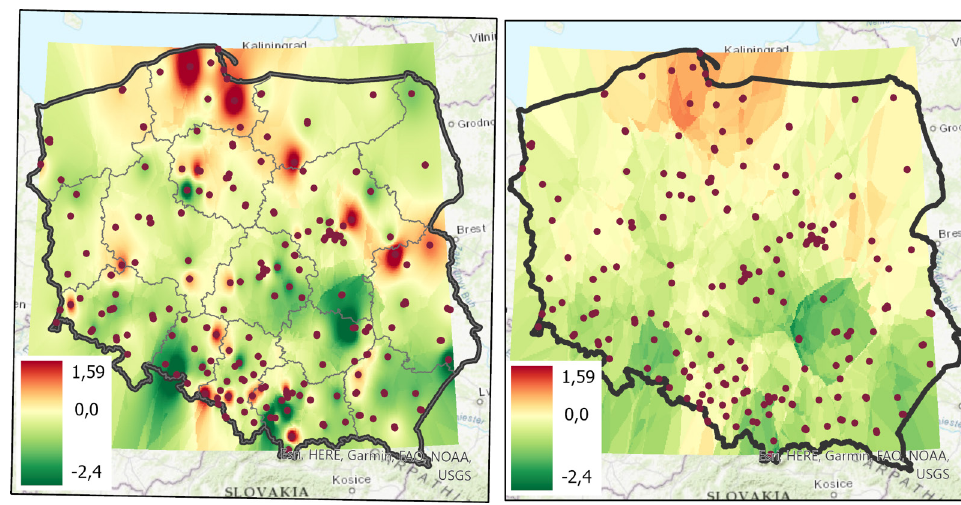
Fig. 7. The trend surface for the change in the value of PM10 concentration in the years (2000–2018),